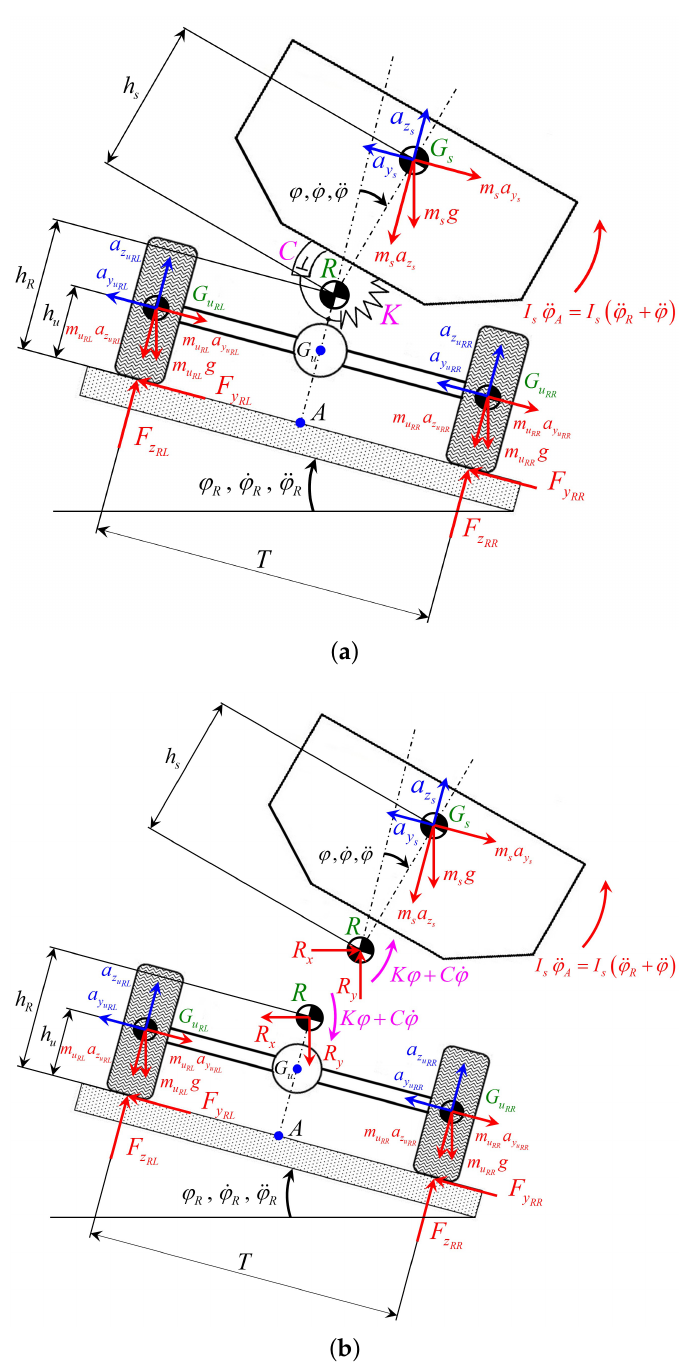
Figure 1. Free body diagrams of: whole vehicle ( a ), sprung and unsprung masses ( b ). The term G groups together the relative vertical dynamics between the left and right unsprung masses and it is defined as reported in Equation